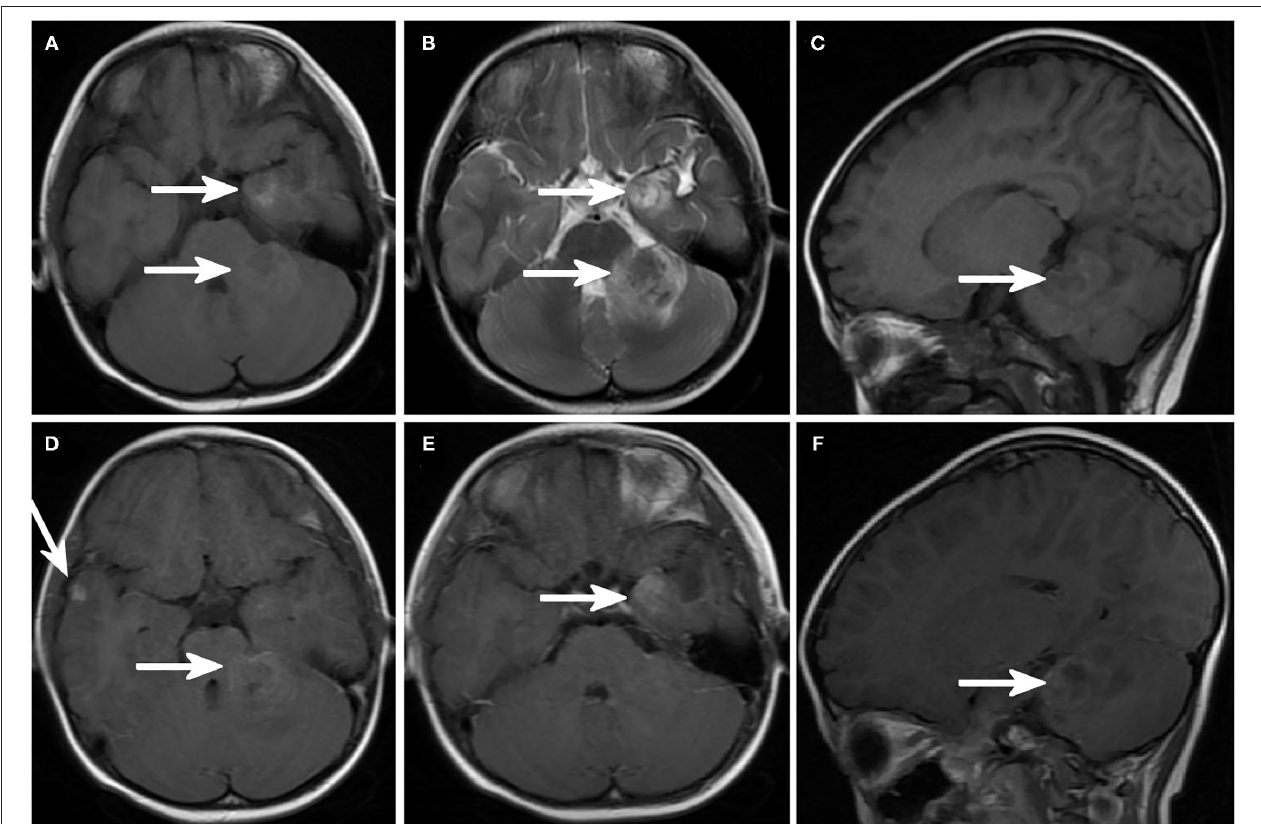
FIGURE 2 | Brain magnetic resonance imaging (MRI) showing intracranial metastatic lesions. (A) Axial T1-weighted image and (B) axial T2-weighted image demonstrated a lesion in the left temporal lobe and left cerebellar hemisphere with prominent cerebral edema around the lesion. Sagittal T1-weighted image (C) showed a cerebellar lesion. (D–F) Enhanced MRI sagittal T1-weighted image and (D) right temporal lobe and left cerebellar hemisphere lesions. (E) Enhanced sagittal MRI image showed left cerebellar hemisphere lesions.